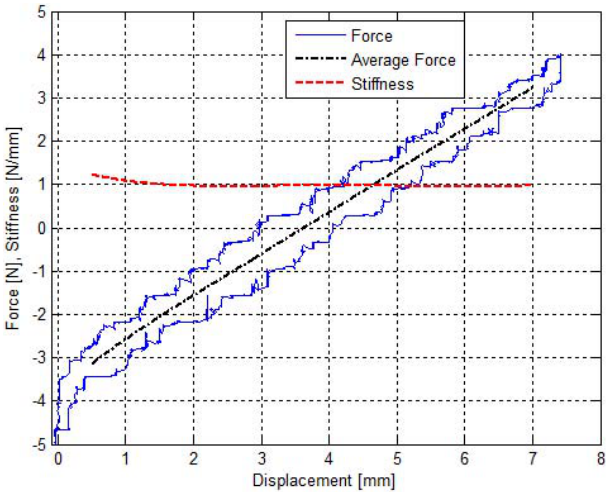
Figure 8. Force-displacement and sti ff ness curves of the compliant grasper from the measurement.